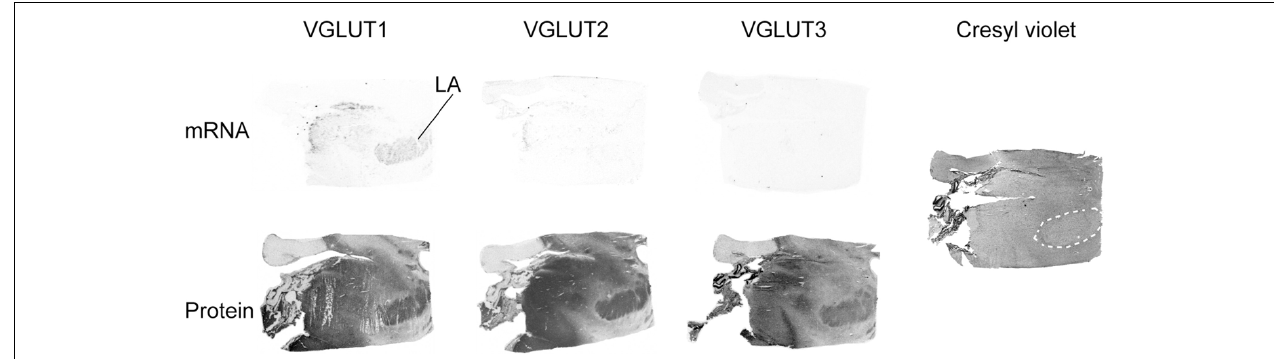
FIGURE 5 | Distribution of VGLUT1-3 mRNA and protein in the amygdala. In addition to the in HIS and immunoautoradiographic labeling, the histological staining of an adjacent section is shown on the left. Abbreviation: LA, lateral